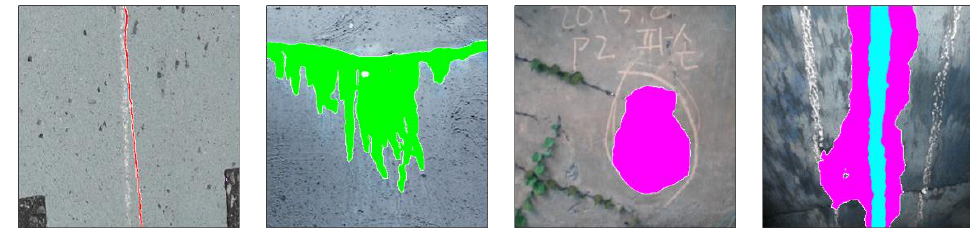
Figure 9. Example of prediction results of all models with original images and ground truths. Figure 10 illustrates some of the prediction results for all models with multiple clas- ses and background noise. Noise in the background, or varied lighting conditions, in an image can significantly impact the performance of a deep learning model. For this pur- pose, the performance of each model was analyzed and compared. The first example in- cludes the prediction of crack and spalling classes in parallel. Only CGNet predicted both types of damage in the lightweight models; however, certain spalling pixels were not pre- dicted. DDR-23-Slim and DeepLabv3+, meanwhile, predicted spalling in the same manner as CGNet. In the case of spalling and rebar exposure, all models, except CGNet and DeepLabV3+, failed to detect rebar exposure. In the last example, in Figure 10, the image contained only cracks, and in the background, some stones were visible at the right corner of the image. In the prediction of all models, except DeepLabV3+, there were false alarms and missing crack labels. ESNet and DDRNet-23-Slim failed to predict cracks. CGNet pre- dicted cracks more accurately than ENet; however, stones in the background were pre- dicted as spalling. As in all examples, the DeepLabV3+ model predicted damage effec- tively, irrespective of any background conditions. Comparing the performance of other models with DeepLabV3+ indicated that the CGNet model predictions in complex back- ground conditions, or with multiple labels, were better than those of the other models.